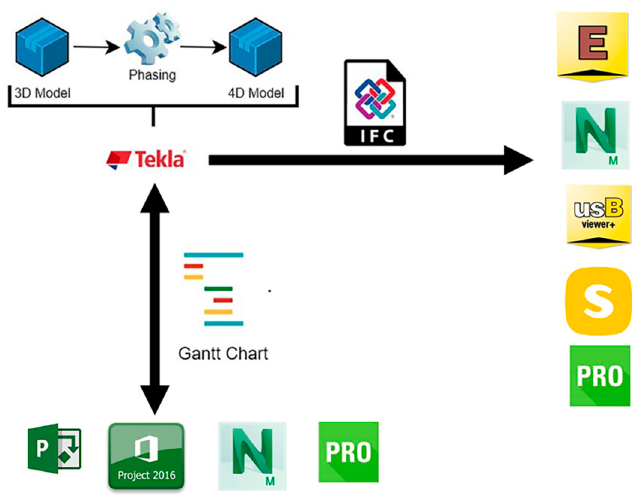
Figure2. Figure 2. Workflow summarizing the three approaches followed for assessing data exchange procedures.